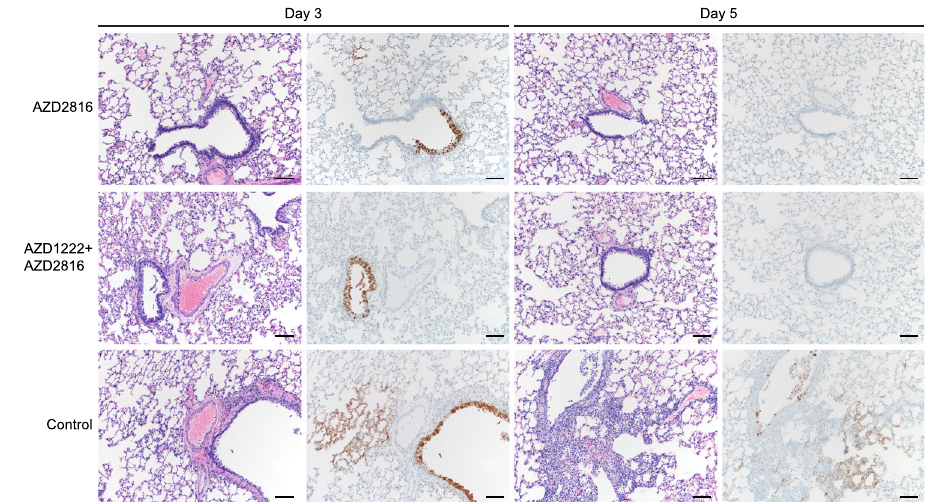
Fig. 5 | Pulmonary effects of intranasal challenge with the Delta VoC in vacci- nated and control hamsters at day 3 and 5 post challenge. H&E staining (1 st and 3 rd column) and IHC staining against N protein (brown, 2 nd and 4 th column), 100x, scale bar=100 µ m. N =6. Limited bronchiolitis with epithelial cell